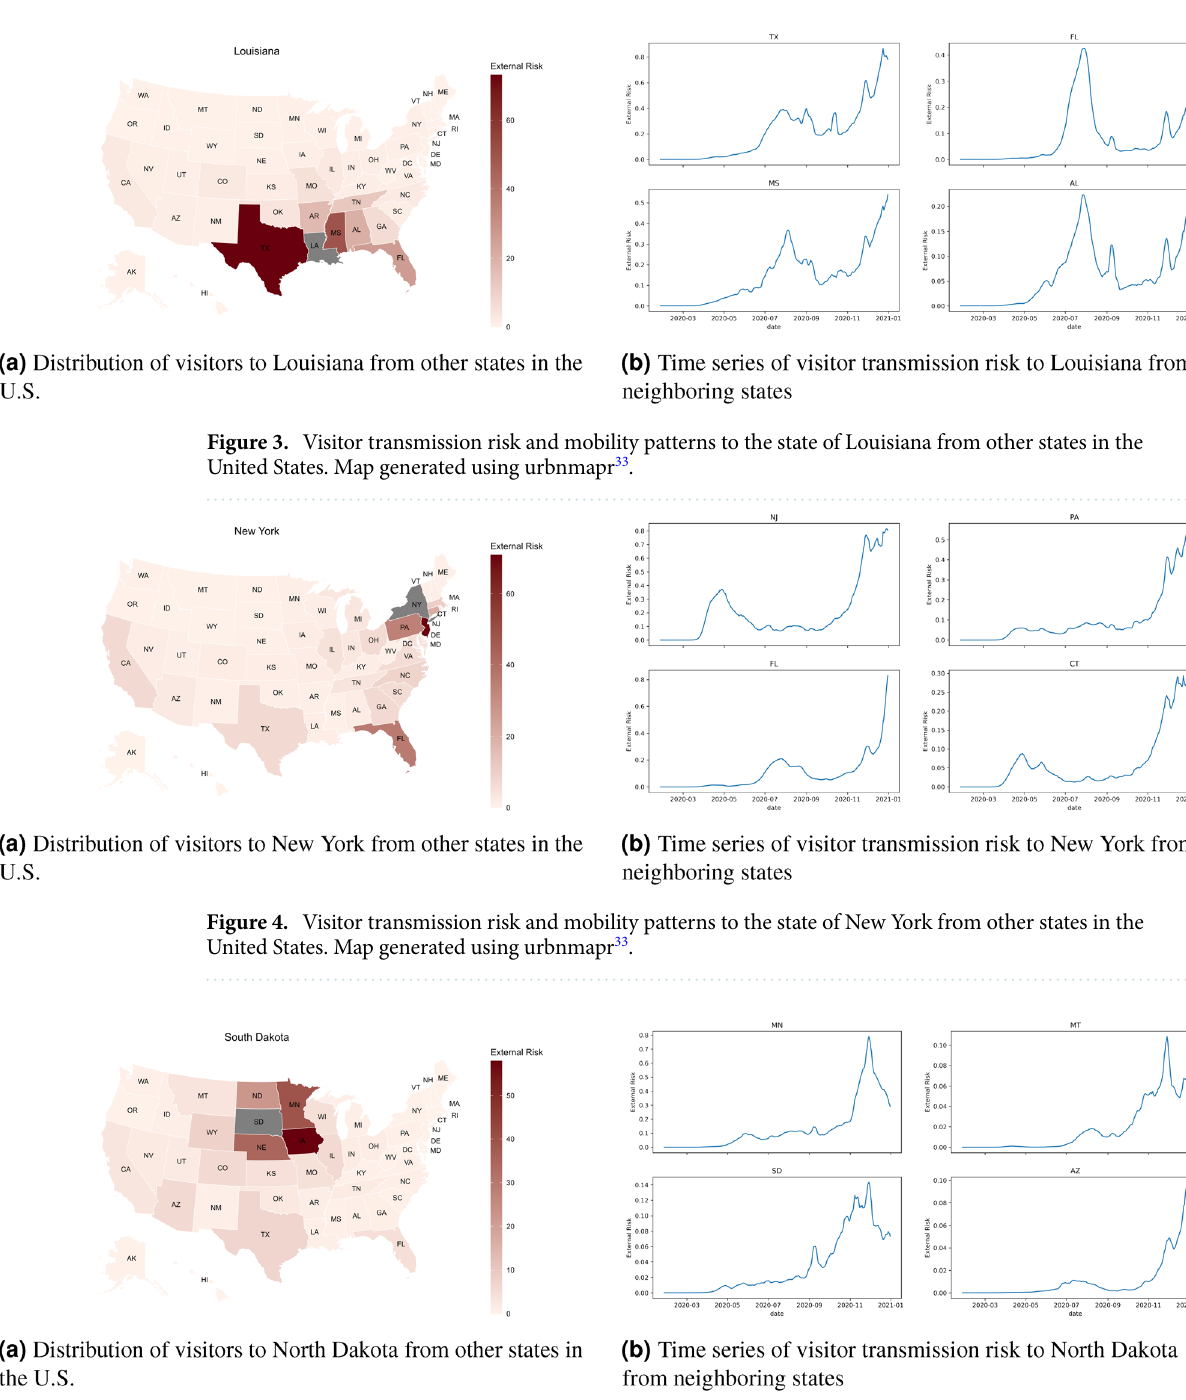
Figure 5. Visitor transmission risk and mobility patterns to the state of North Dakota from other states in the United States. Map generated using urbnmapr 33 .